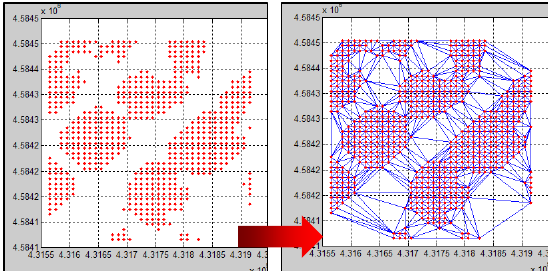
Figure 4: (Up) Pixels (points) embedded by image objects such as buildings, Barcelona city, 2004. Figure 5: (Down) Delaunay triangulation deployed in all building pixels.